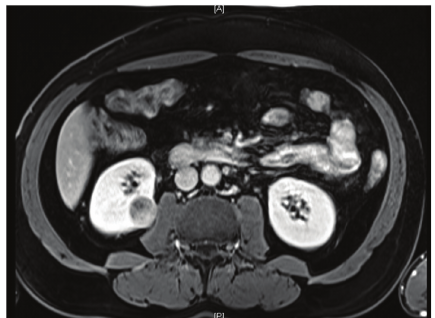
Figure 2: Axial MR image of a 56-year-old male patient who has presented due to an incidentally diagnosed right renal mass. Tumor was measuring 2.8 cm in its greatest dimension and R.E.N.A.L. score was 8. He was managed by off-clamp RANSS. Eventual histopathologic diagnosis was Fuhrman grade 3, pT1a, and papillary